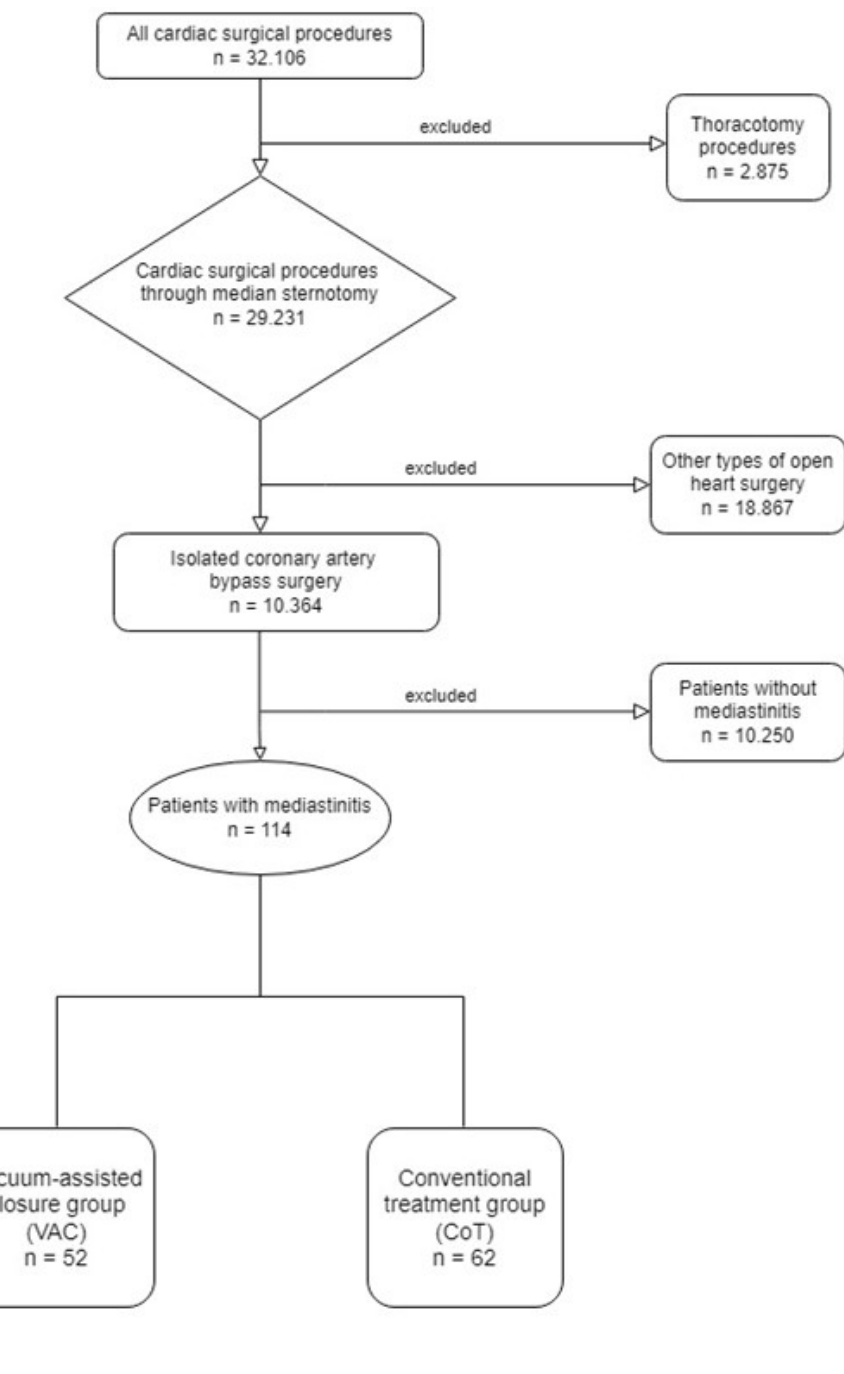
Fig. 1 - Flow chart of the study